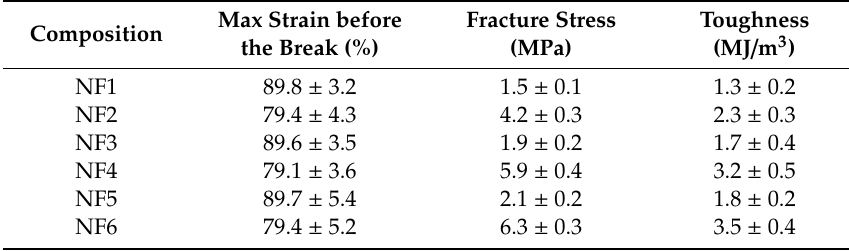
Table 3. Dependency on mechanical properties of nanofibrous webs based on a polymeric blend with PVA, including maximum strain at break, fracture stress, and